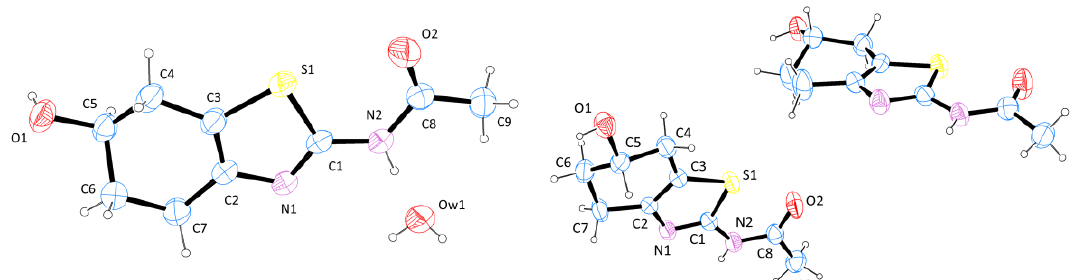
Figure 4. ORTEP [32] drawings of ( R )- 4 (left) and ( S )- 4 (right), with the arbitrary atom numbering (ellipsoids are at 40% probability and H atoms are represented as spheres of arbitrary radii). In ( S )- 4 , the A-labeled molecule in the asymmetric unit (ASU) follows the scheme reported for the other molecule.